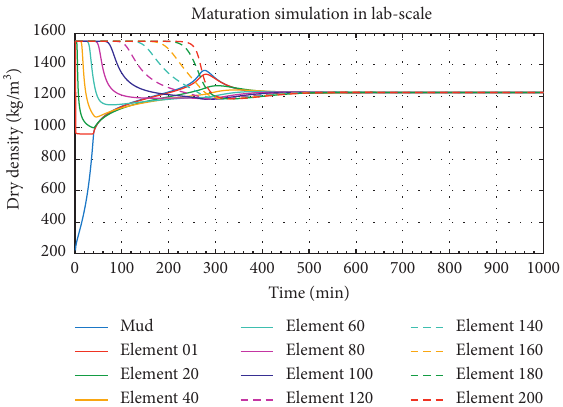
Figure 5: Maturation of clay seals in simulation with 200 elements. Plotting with mud and every 20th